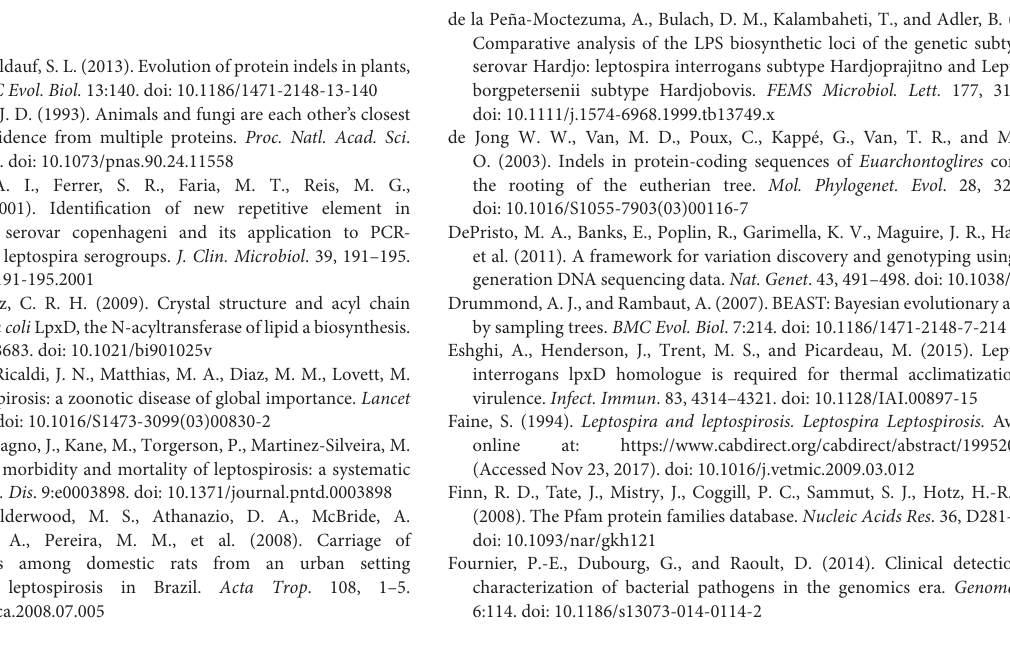
Figure S1 | Bayesian maximum clade credibility phylogenetic tree. The tree was constructed using the relaxed molecular clock model and Bayesian Skyline Plot population size model. The branch support is given by posterior probability > 0.88 and is indicated with an asterisk ( ∗ ). The tree branches are colored by country. Figure S2 | MacClade analysis. Identification of the migration relation between strains from different geographic locations. The selected regions were Brazil (BR), United States (US), Slovenia (SL), Egypt (EG) Guyana (GY), Guadalupe (GP), European Union (EU), French Polynesia (FP), Colombia (CO), and Japan (JP). Figure S3 | Gene expression analysis of lic12008 in L. interrogans serovars. Real-time PCR analysis of lic12008 transcript in L. interrogans serovar Icterohaemorrhagiae strains (201000456 and 201000458) by employing primer pairs (12008 T1 and T2). Fold change was calculated by using the 2 − 11 Ct method. Data was normalized by the amount of flaB transcript expressed relative to the corresponding value for L. interrogans serovar Copenhageni L1-130 and is expressed as mean ± SD. Table S1 | General information list of all the Leptospira interrogans strains of the serogroup Icterohaemorrhagiae used in this study. Table S2 | Validation rate for the pipeline call for SNPs. Table S3 | Validation rate for the pipeline call for Indel. Table S4 | Sequencing and mapping quality.